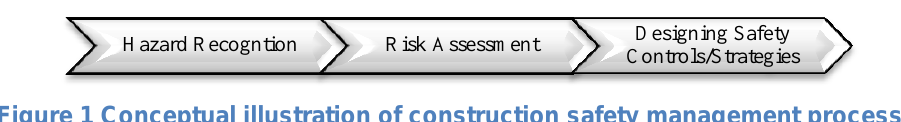
Figure 1 Conceptual illustration of construction safety management